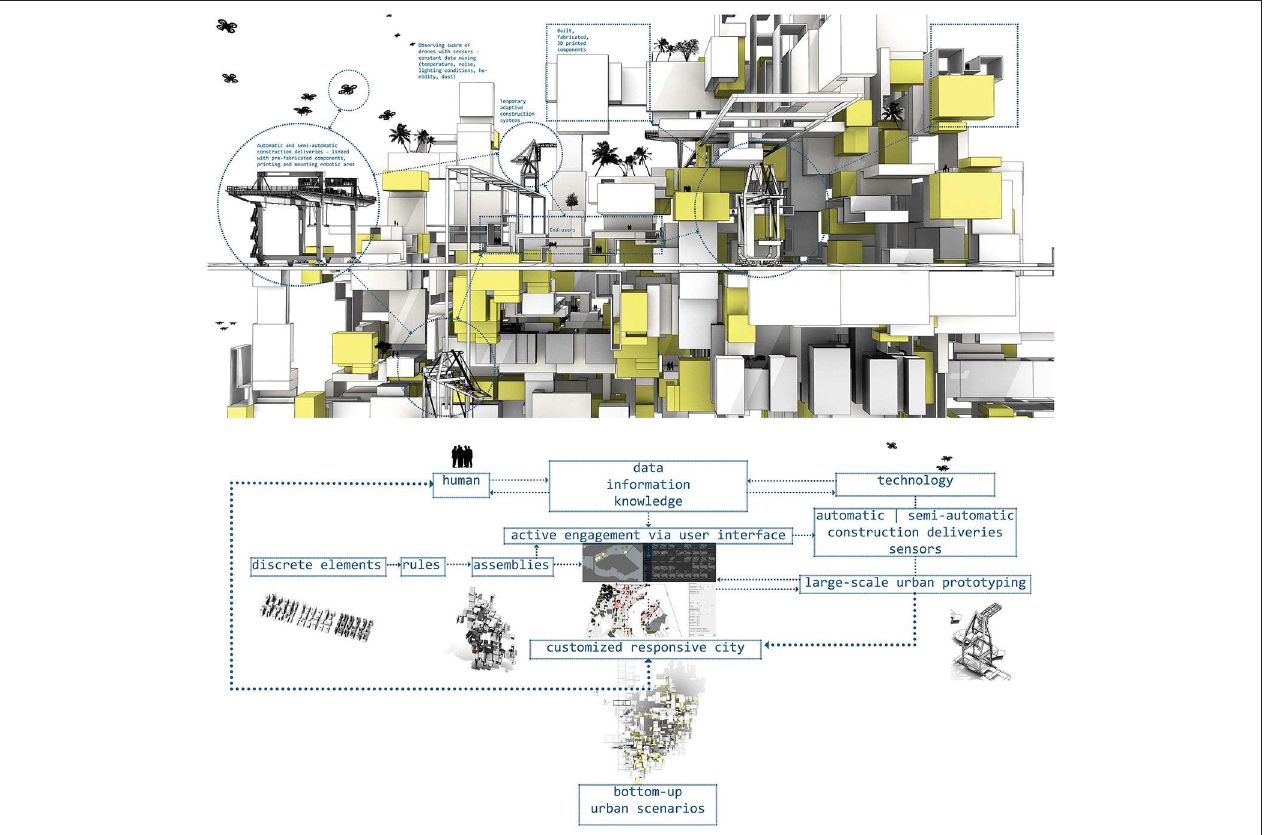
FIGURE 2 | Scaffolding and supporting systems as an integrated part of the city infrastructure. Perspective view of the adaptive neighborhood with the process illustrating the relations between particular components in the responsive